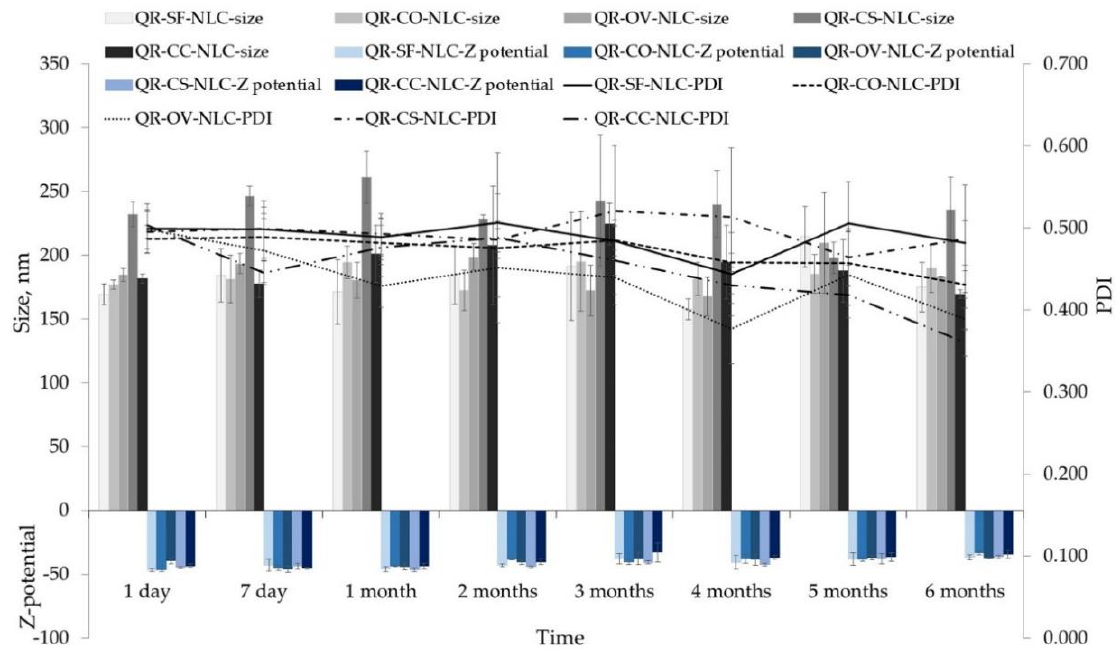
Figure 5. Long-term stability of QR-NPO-NLCs during a 6-month period; 0.5% QR ( w / v ).